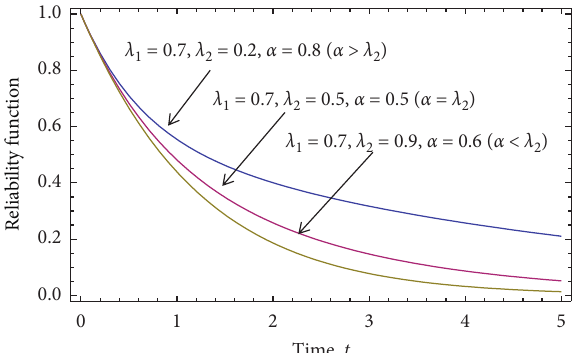
and rate of completion of warranty α . 2